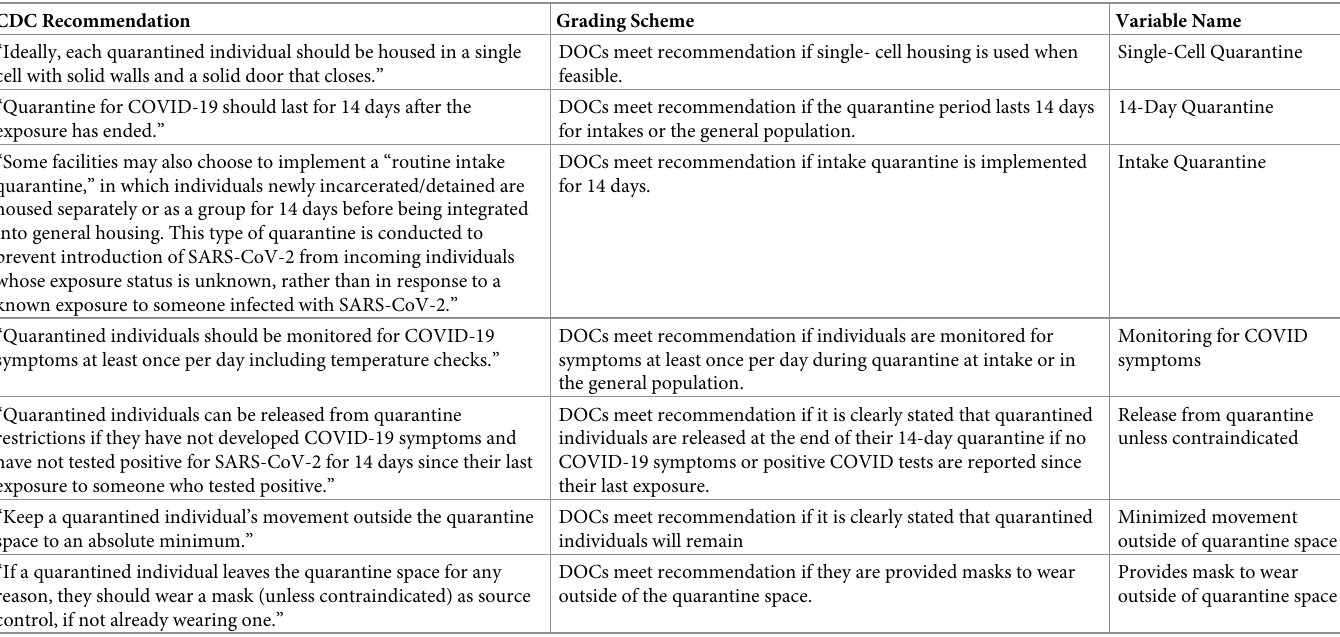
Table 1. CDC recommendations for quarantine in correctional